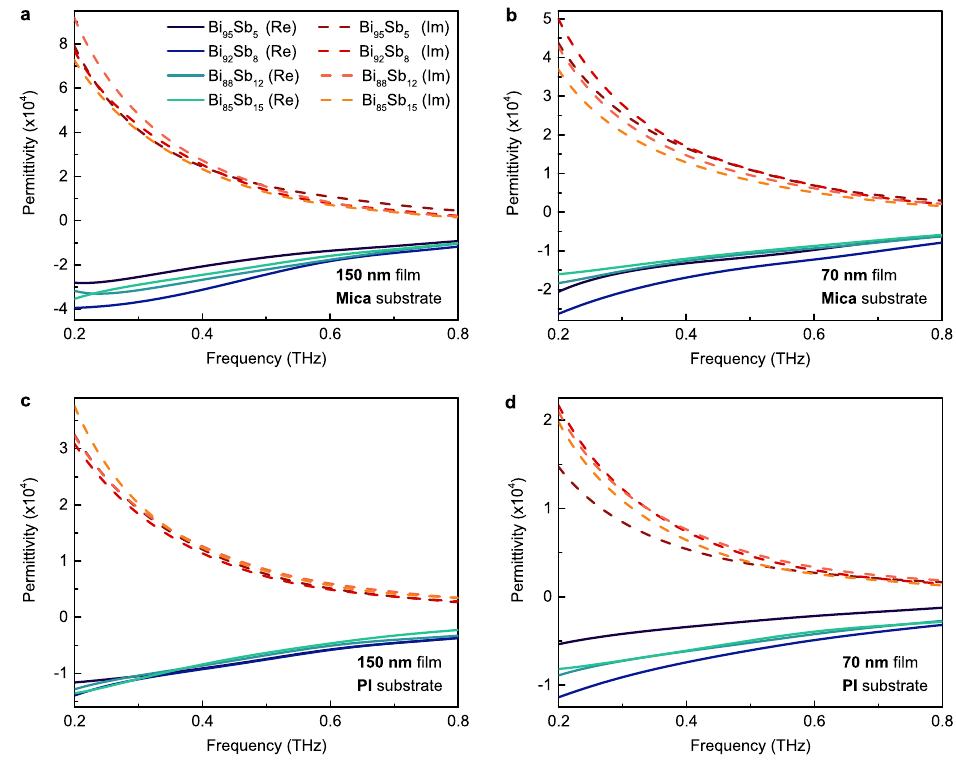
Figure 5. The dynamical complex permittivity spectra of Bi 1 − x Sb x films in 0.2–0.8 THz frequency range for the cases of mica ( a , b ) and PI ( c , d ) substrates and for 150 nm ( a , c ) and 70 nm ( b , d ) film thicknesses. Different colors represent different Sb concentrations. The solid and dashed lines represent the real and imaginary parts of permittivity,